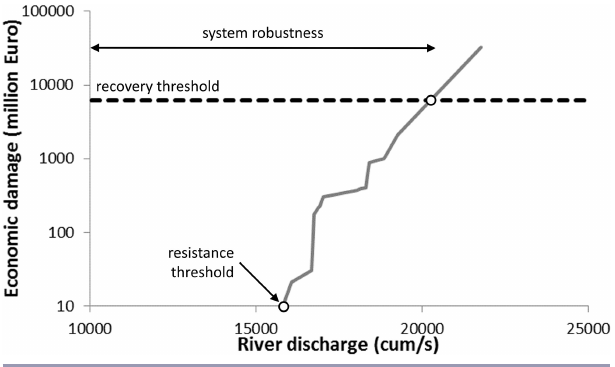
Fig. 1 . Response curve of a flood risk system (adapted from Mens et al.